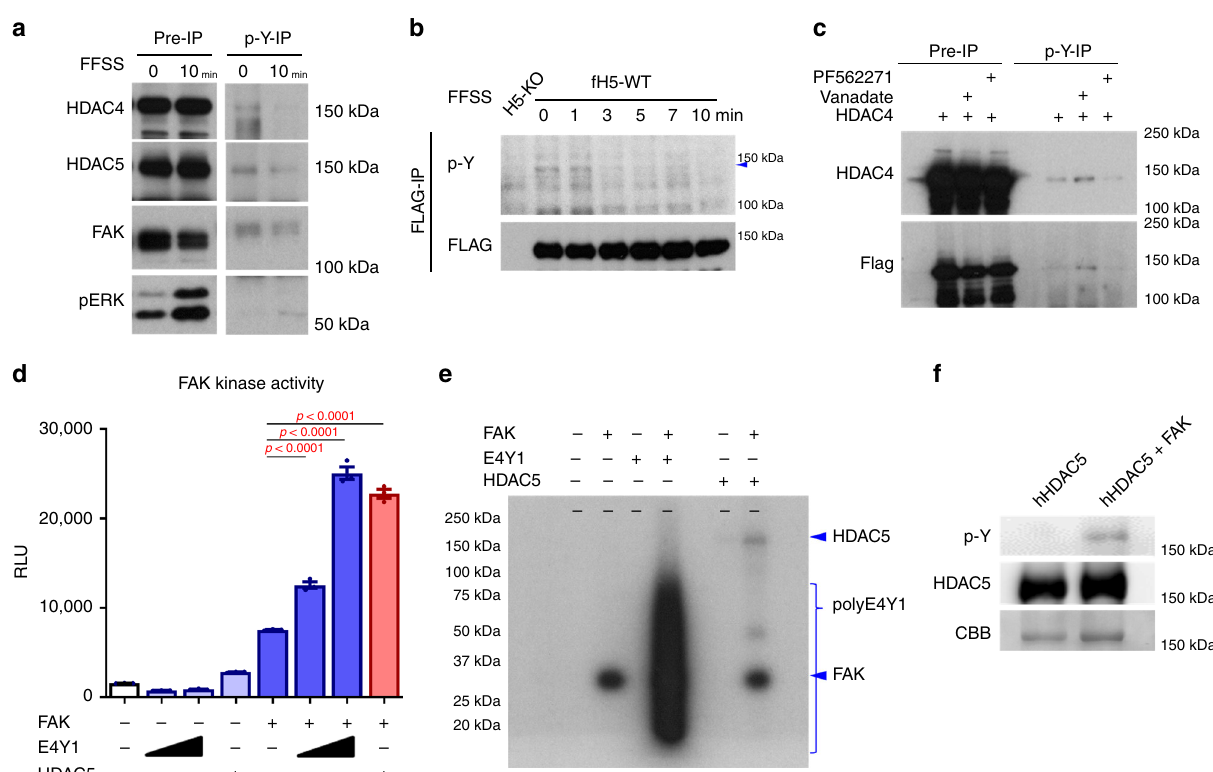
Fig. 5 FAK-mediated class IIa HDACs tyrosine phosphorylation is regulated by FFSS. a Immunoprecipitation by anti-phosphotyrosine (referred to as “ p- Y-1000 ” throughout) antibody. FFSS was performed for 10 min with Ocy454 cells. Phosphotyrosine immunoprecipitation was performed on cell lysates treated as indicated, and protein expression was determined by western blotting. FFSS reduced HDAC4 and HDAC5 with p-Y-1000 immunoprecipitation. b FLAG immunoprecipitation was performed in HDAC5-de fi cient cells stably expressing FLAG-HDAC5, subjected to FFSS for times as indicated. phospho- HDAC5 was decreased in a time-dependent manner. c HEK293T cells were transfected with FLAG-HDAC4, then treated for one hour as indicated with PF562271 (10 µ M) or vanadate (1 mM) followed by phosphotyrosine immunoprecipitation and then immunoblotting. Tyrosine-phosphorylated HDAC4 was increased by vanadate treatment and decreased by FAK inhibitor treatment. P -values adjusted for multiple comparisons vs control are shown. d FAK kinase activity was measured by ADP-Glo kinase assay. E4Y1 (poly(Glu)/poly(Tyr) ratio of 4:1) polypeptides were used as a control substrate of FAK tyrosine kinase. Increased FAK kinase activity was detected when recombinant human HDAC5 protein was used as a substrate. e Recombinant human HDAC5 and E4Y1 (a control substrate) were incubated with ɣ -32P-ATP and FAK tyrosine kinase for 1 h, then separate by SDS-PAGE followed by autoradiography. FAK treatment showed ɣ -32P-ATP-positive band at the expected HDAC5 recombinant protein size. f Kinase assay reactions as in e were separated by SDS- PAGE followed by immunoblotting as indicated. CBB indicates Coomassie Brilliant Blue stain. One-way ANOVA followed by Tukey – Kramer post hoc test was used ( d ). Data are expressed as mean ± SEM. Each experiment was repeated three times ( a – c, e, f ). Source data are provided as a Source Data fi